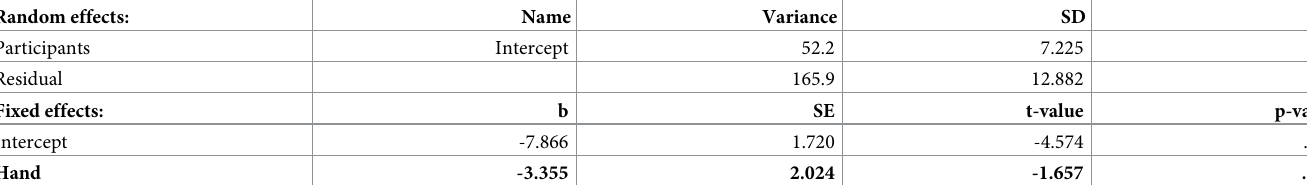
Table 11. Model 3.1. Main effect of Hand on grip force in the time window 880–970 ms (not significant; Experiment 3).